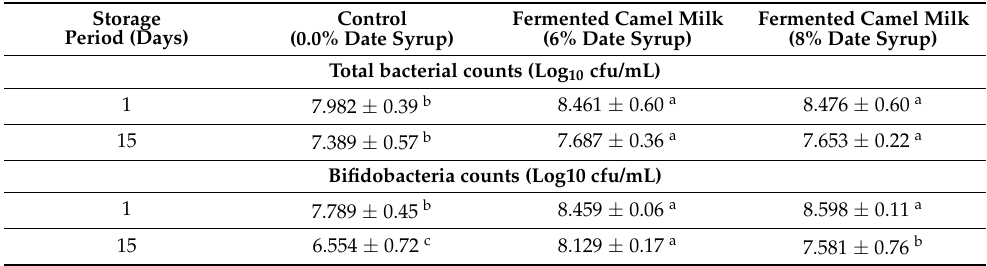
Table 6. Influence of date syrup addition on the total bacterial and bifidobacteria counts of camel milk yogurt during the cooled storage